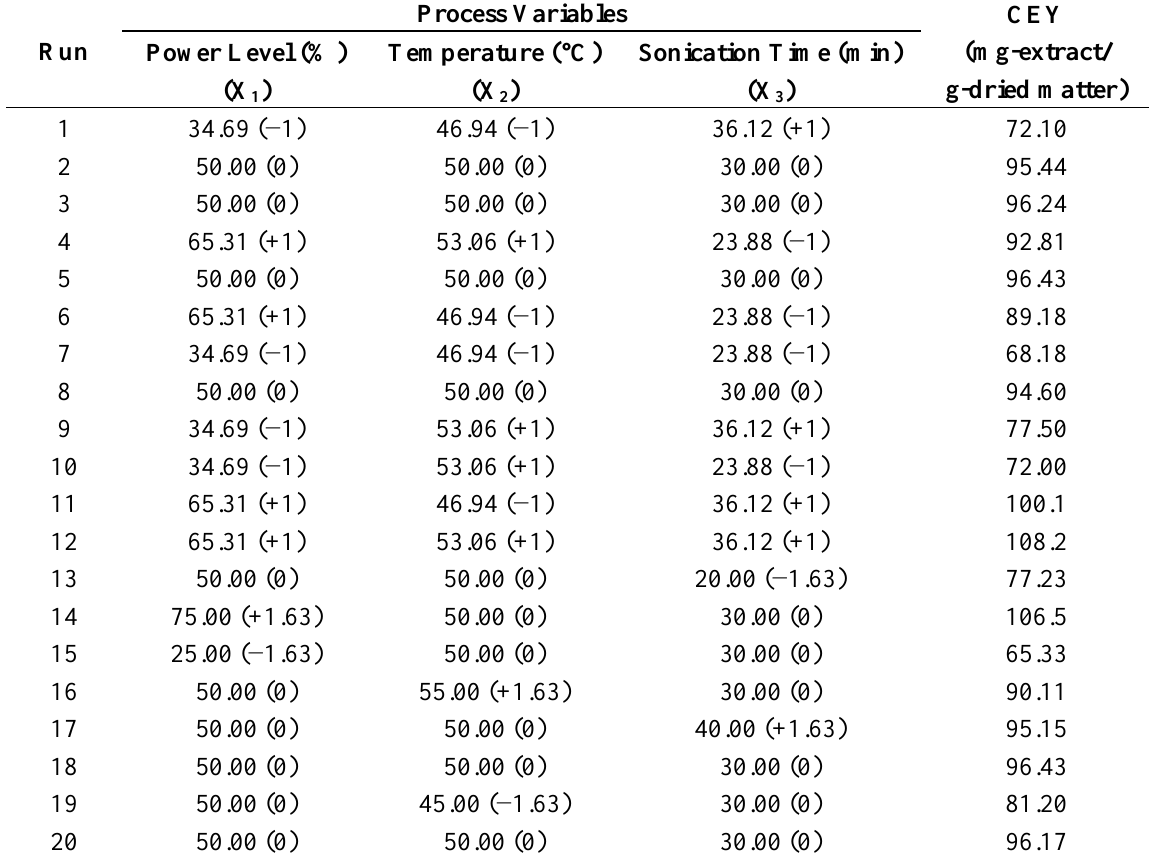
Table 1. Experimental design (coded and uncoded levels) and results of response variable. Process Variables CEY Run